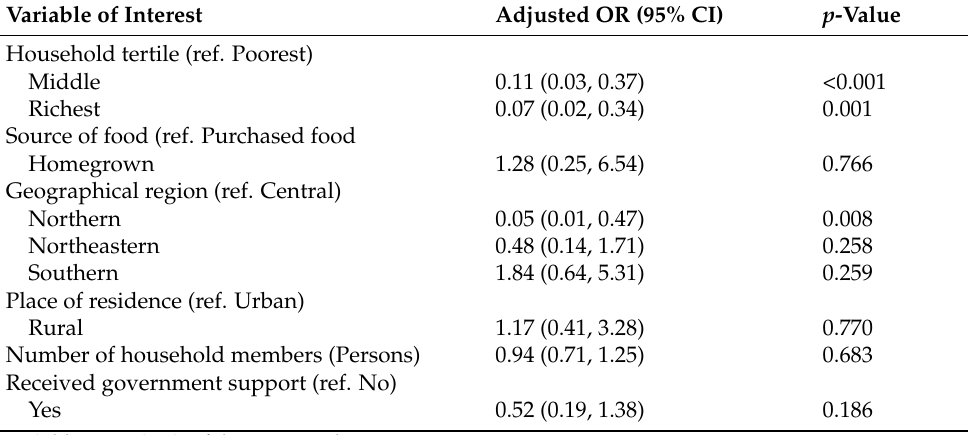
Table 3. Association between socio-economic status and food insecurity among households: multiple logistic